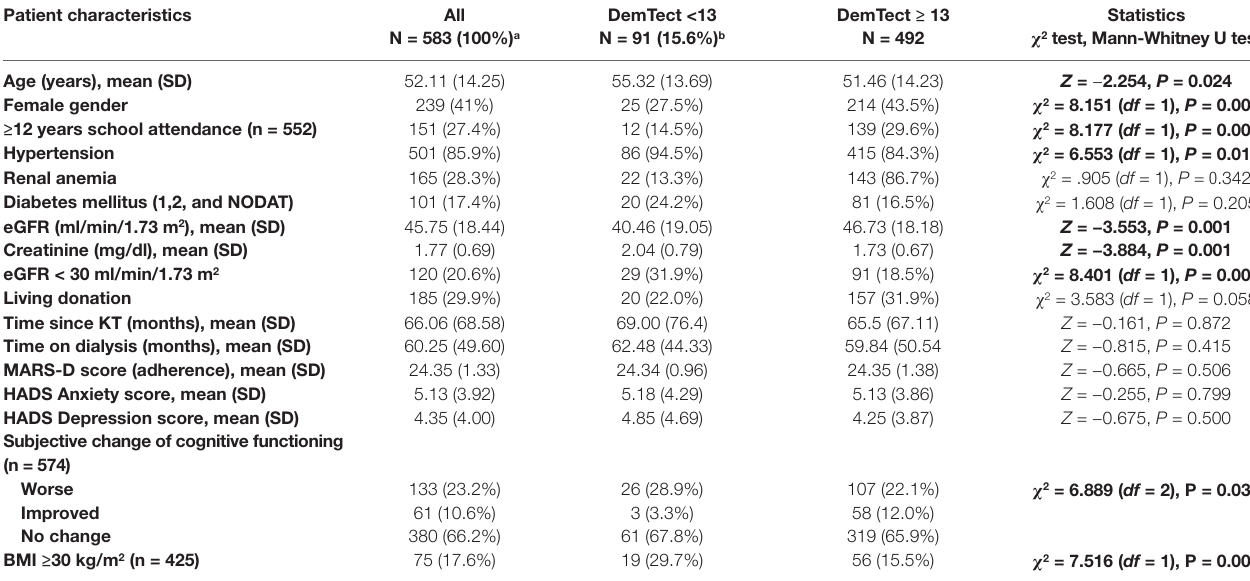
TaBle 2 | Comparison of demographic and clinical characteristics between KTx patients with and without cognitive impairment. Patient